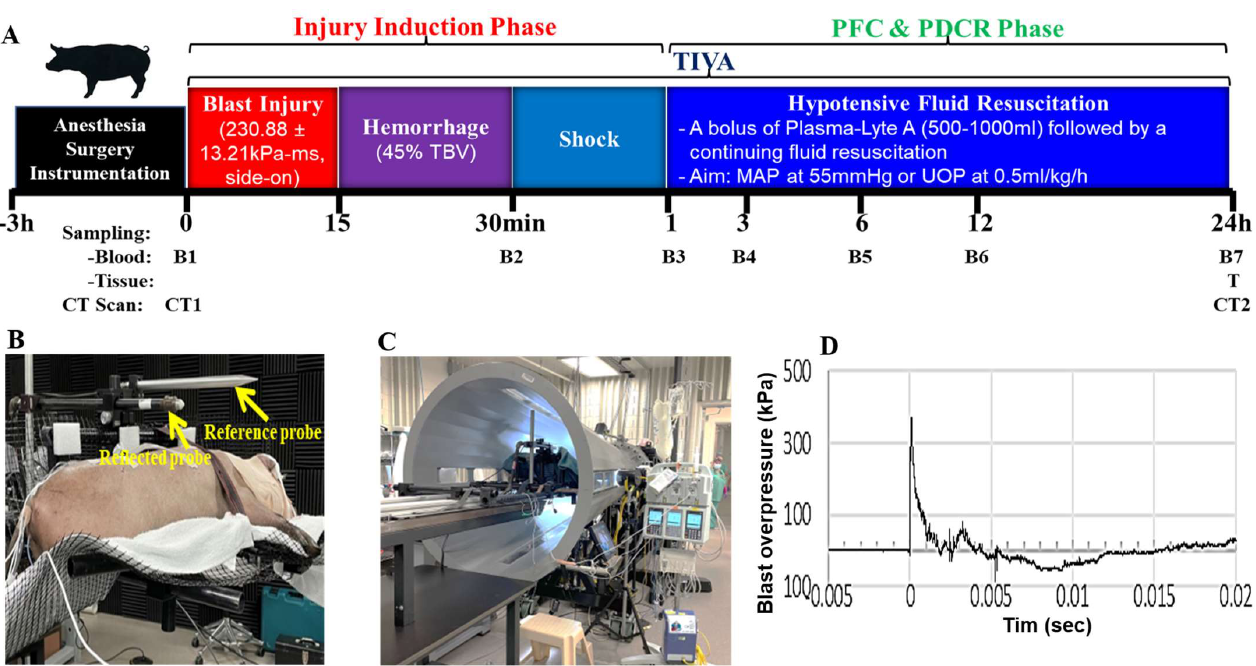
Figure 6. Schematic showing the experimental design and time frame of BI+HS in swine ( A ), pig in mesh holder outside ( B ) and inside ( C ) shock tube, representative blast overpressure wave form ( D ).